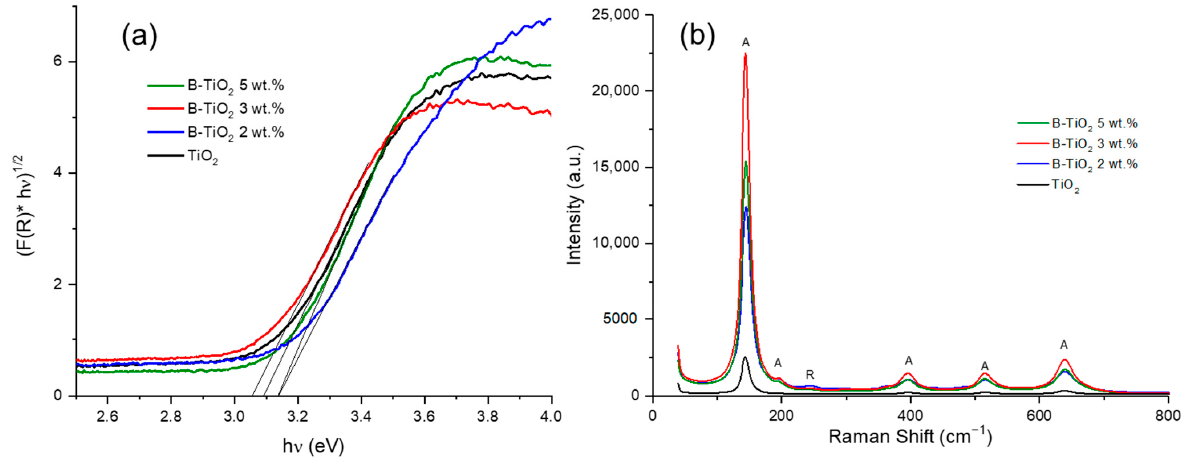
Figure 2. DRS spectra represented as Kubelka–Munk function and ( a ) Raman spectra of ( b ) Pure TiO 2 and B-TiO 2 with different ratios of boron. Table 2. Reaction kinetic parameters using B-doped TiO 2 catalysts.